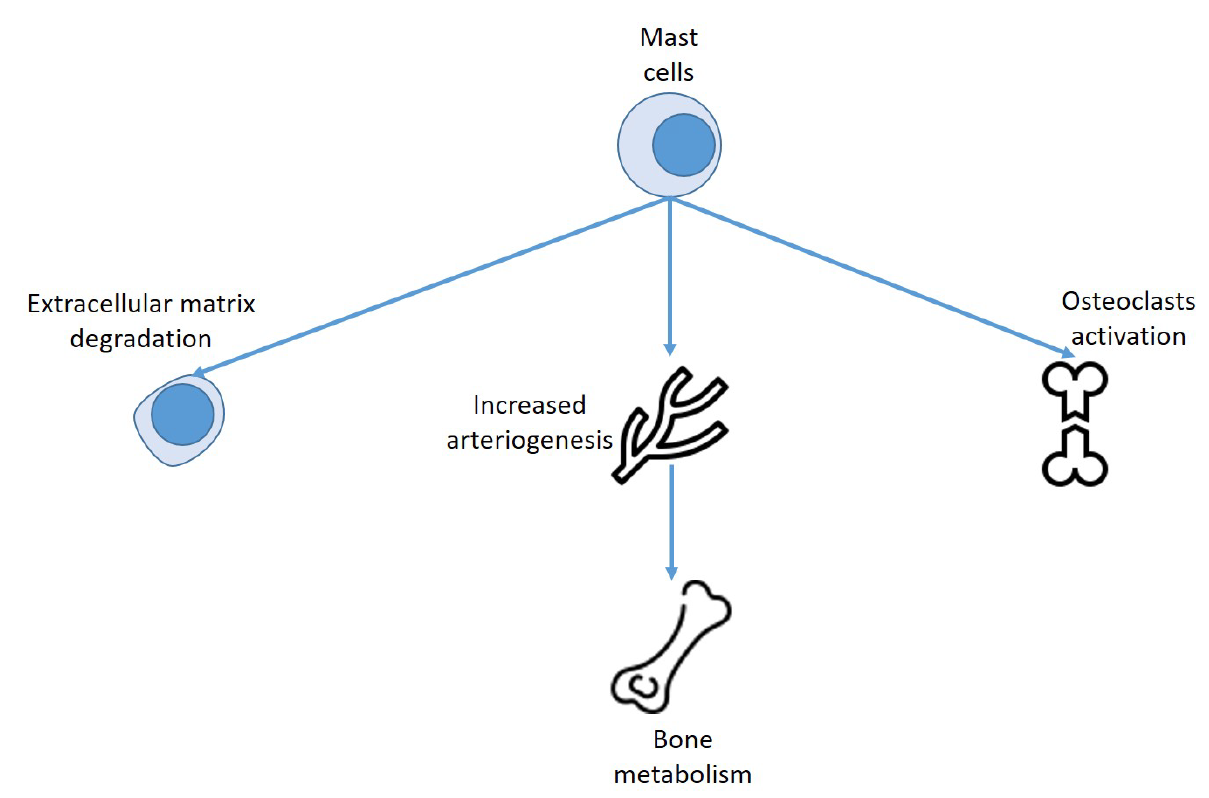
Figure 4. Effect of mast cells on bone metabolism.